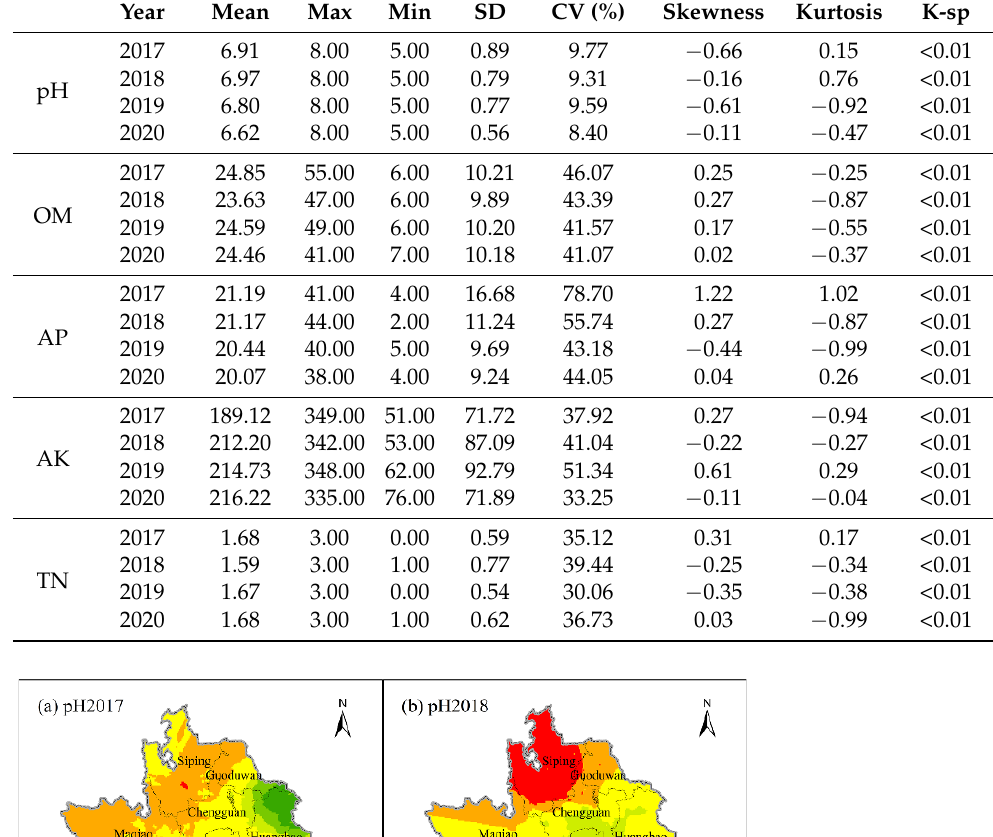
Table 5. Descriptive statistic of the soil chemical property.